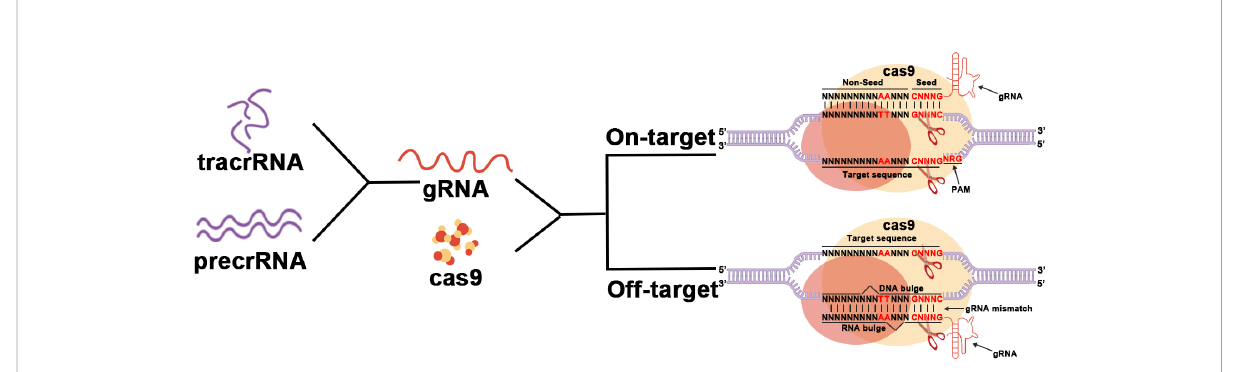
FIGURE 1 The main working procedure of